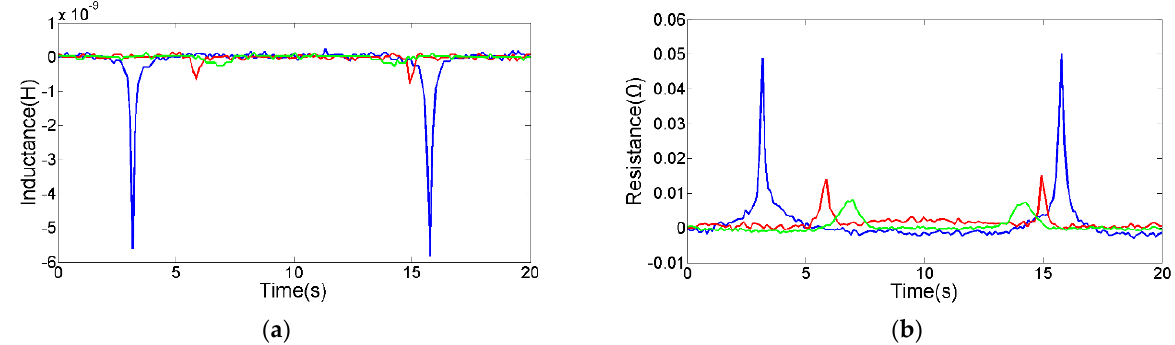
Figure 8. The detection results of 155 µ m spherical copper debris, the green line is the signal from sensing unit C, the red line is the signal from sensing unit B, the blue line is the signal from sensing unit A. ( a ) Inductance signal diagram, ( b ) resistance signal diagram. Table 1. The pulse change values from different sensing units.